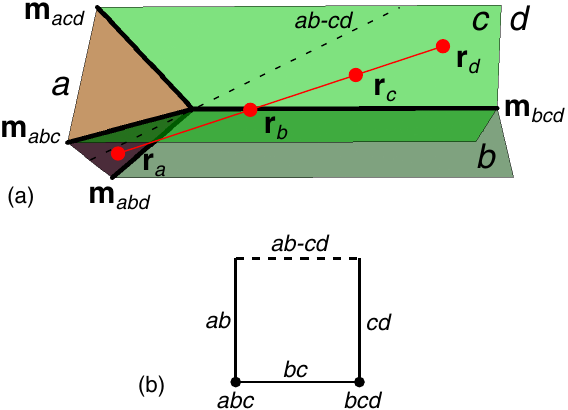
FIG. 14. (a) Representative contribution to the D ¼ 3 integral I in Eq. (D17), with r ( a ¼ A , B , C , D ) integrated over the a boundary of region a . The δ functions in the integrand require r to lie on a straight line (the red line herein); hence, two of A;B;C;D the r ’ s are the same boundary plane. Given a fixed ordering abcd , its contribution to I consists of all possible orientations of the abcd line such that it is parallel to one of the boundaries. (b) Schematic diagram for a one-parameter family of lines with ’ s. Vertex bcd represents the case when fixed distances between r a the abcd line orients along the triple contact ˆ m . Edge cd bcd represents the case when the abcd line rotates on the double contact plane cd [shown in (a)]. Dashed edge ab – cd represents the case when the abcd line lies on both the ab and cd